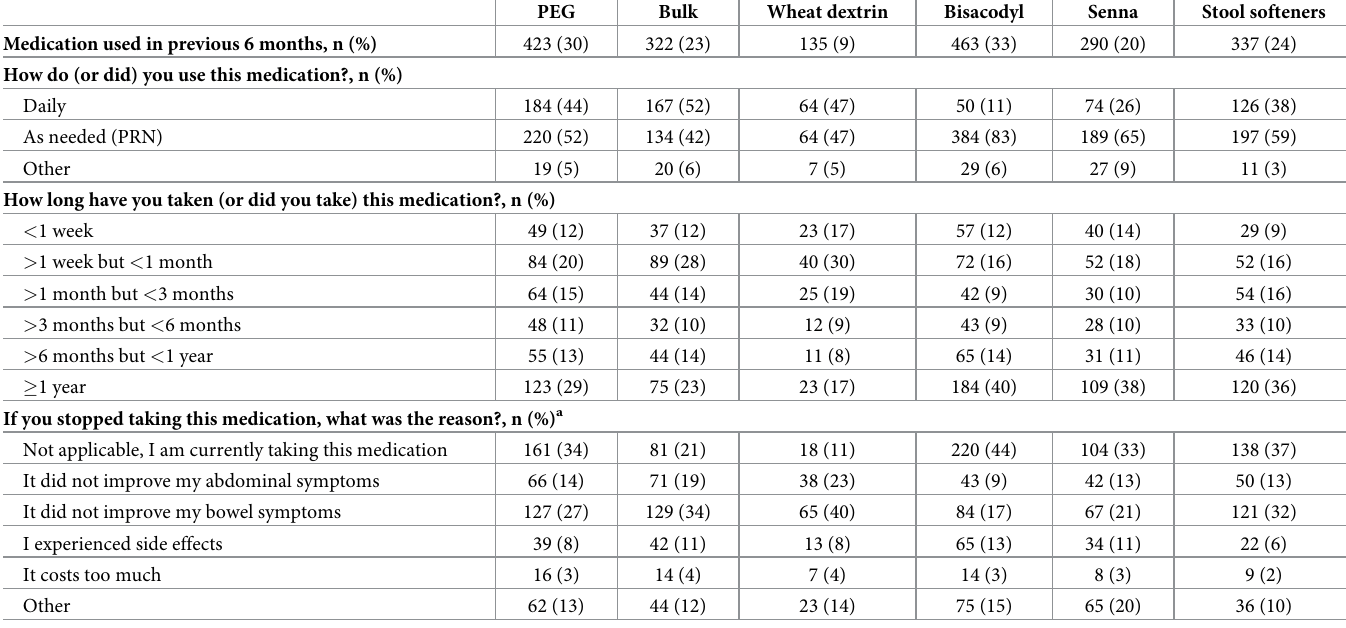
Table 3. Medication use and stoppage (N = 1423). PEG Bulk Wheat dextrin Bisacodyl Senna Stool